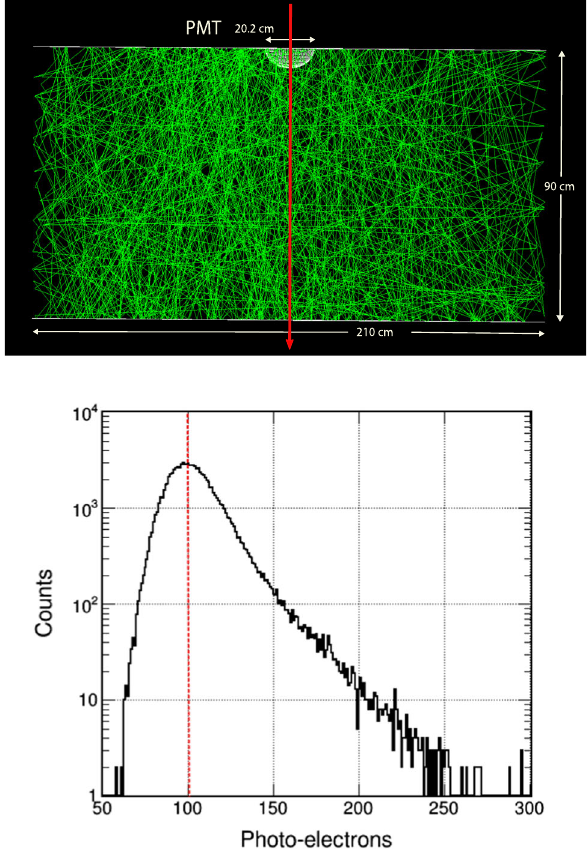
Fig. 5 Top: A vertical and central muon of 3GeV (red arrow) moves through the detector producing thousands of Cherenkov photons (green lines) that are propagated in the water volume and diffusely reflected in the Tyvek® coating. Eventually, these photons can be either absorbed or finallyreach the PMT, producing a certainnumber of photo-electrons (pe). Bottom: distribution of the expected number of pe obtained due to the passage of 10 5 central and vertical muons of E s = 3GeV, peaked at a value of 100pe per VEM, that represents the main unit of calibration for thisparticularsimulateddetector.Byconsideringthe muon stopping power in water at these energies, then 1VEM (cid:2) 100pe (cid:2)